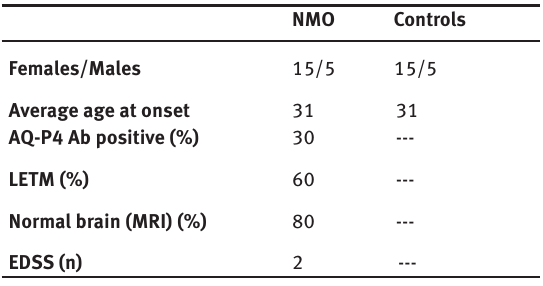
Table 1: Characteristics of NMO patient and control